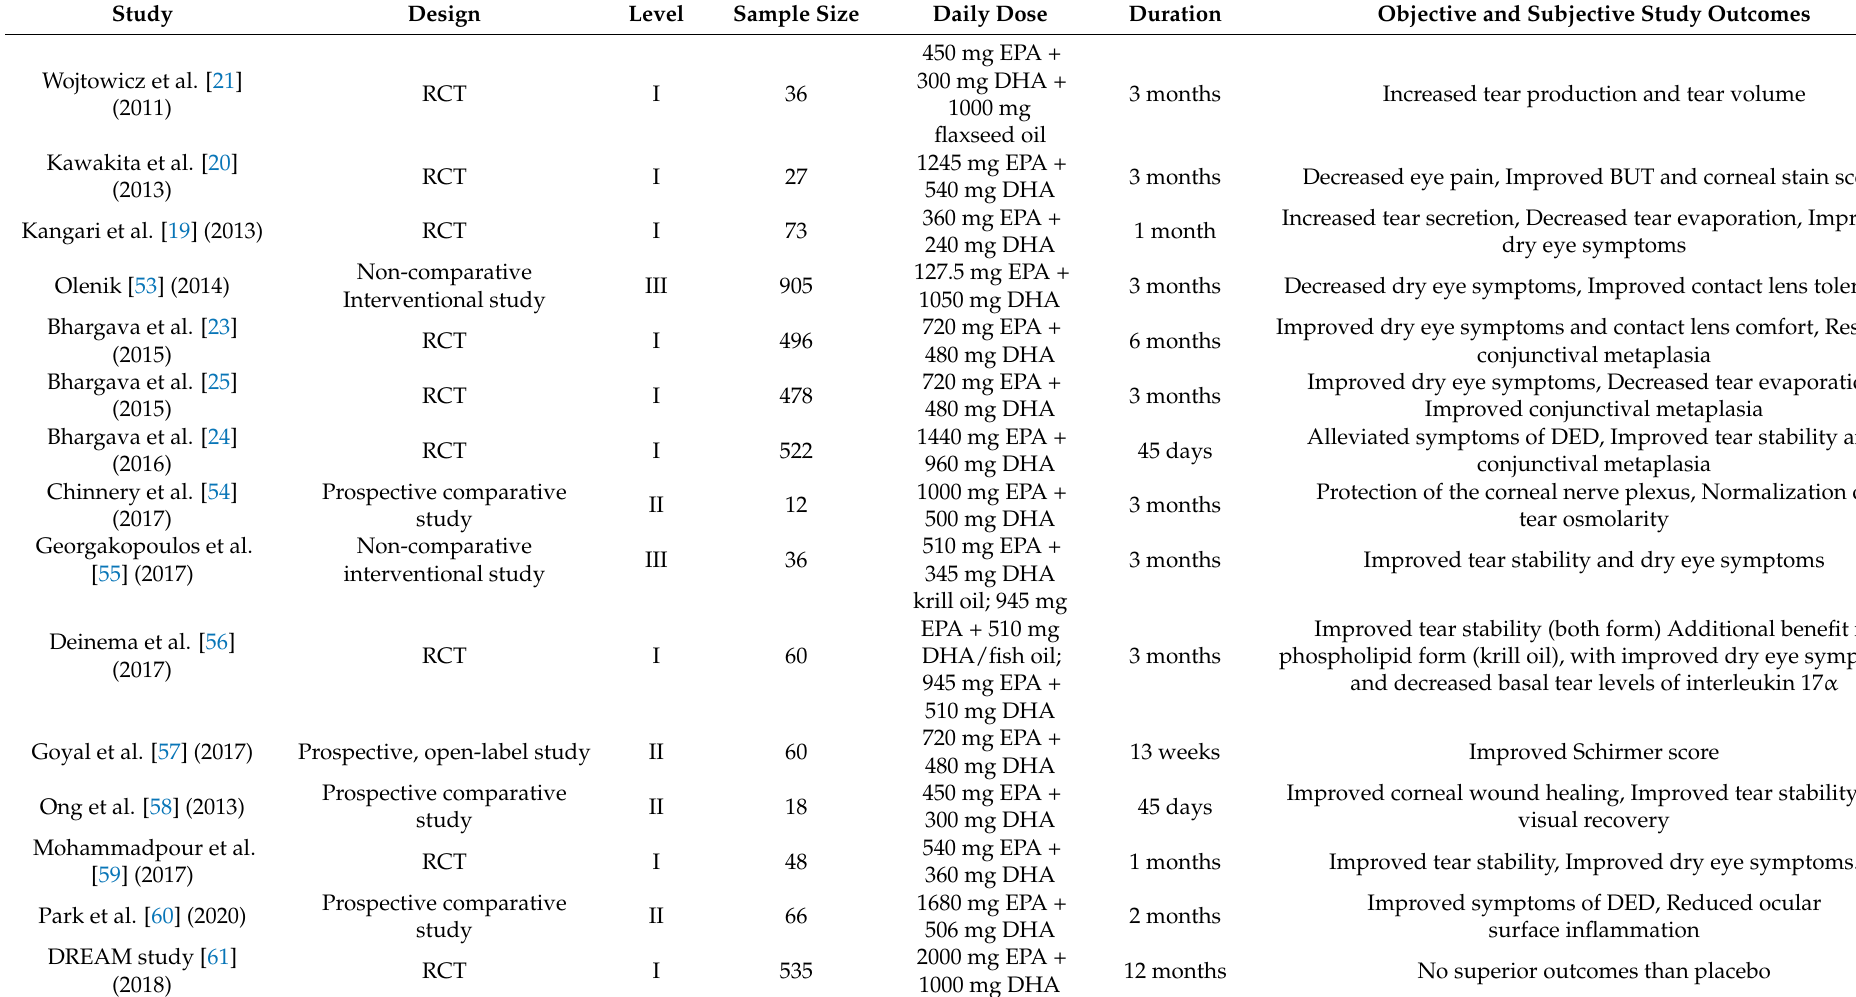
Table 2. Characteristics of clinical trials on the efficacy of ω 3 PUFAs on